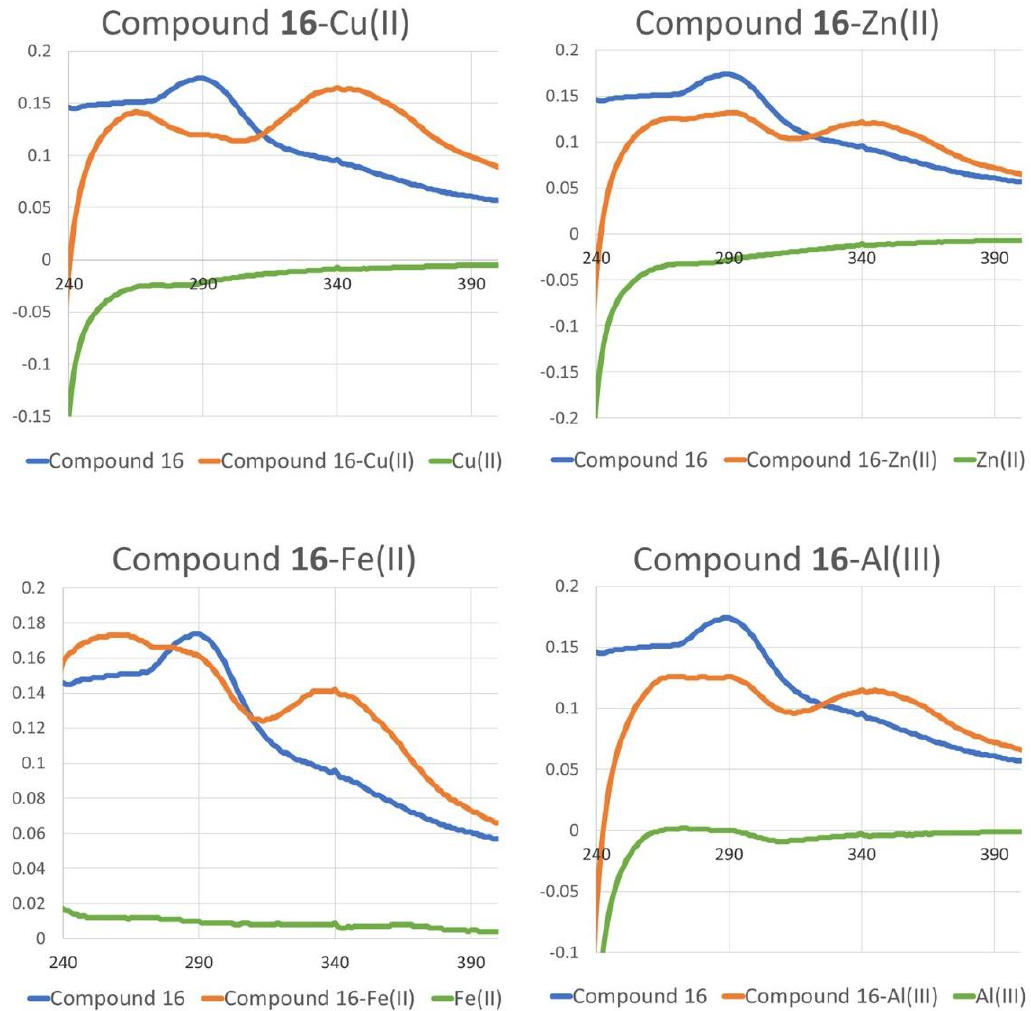
Figure 10. Absorbance spectra of compound 16 in the absence and in the presence of copper ion, zinc ion, iron ion, and aluminum ion (10 µ M) and spectra of copper, zinc, iron, and aluminum ions, determined by UV-Visible spectroscopy with water/DMSO (90:10) as the solvent.